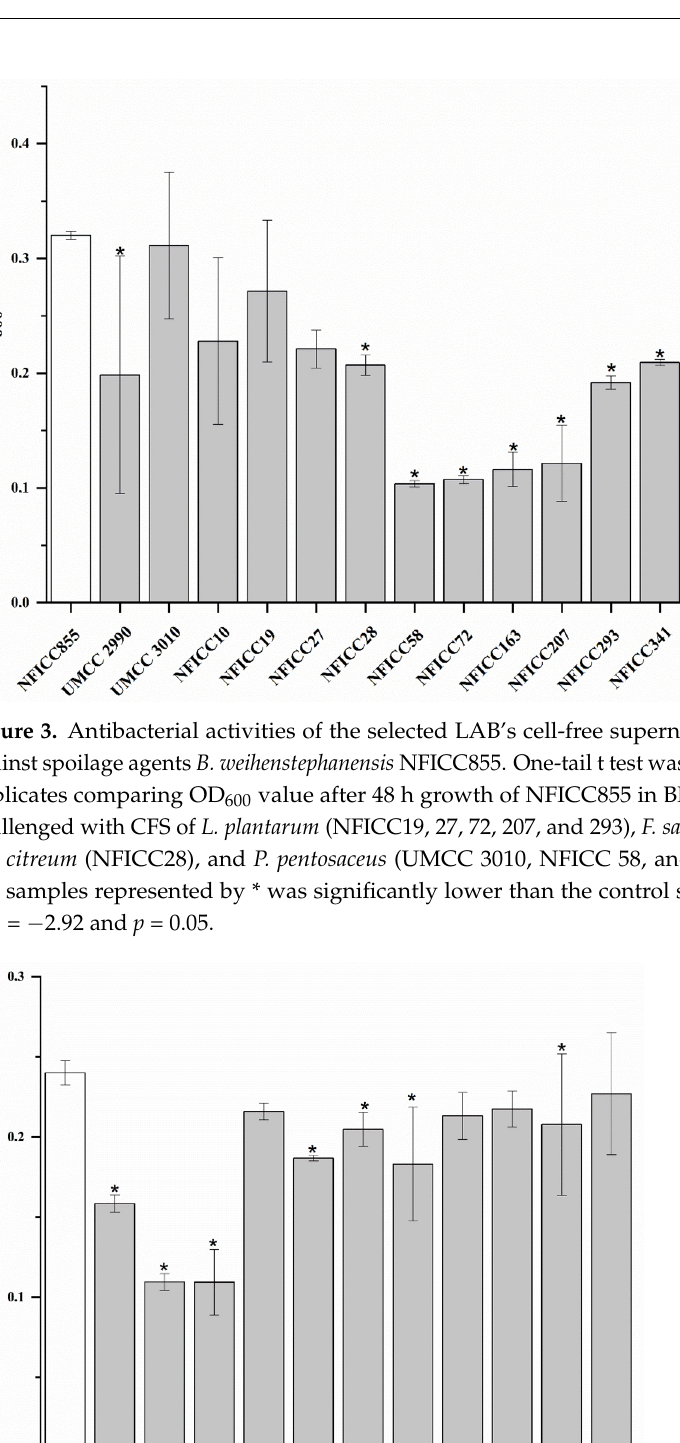
Figure 5. Antibacterial activity of the selected LAB’s cell-free supernatant in Bread Media (BM) on spoilage agent B. amyloquiefaciens NFICC 1127. One-tail t test was performed on the obtained